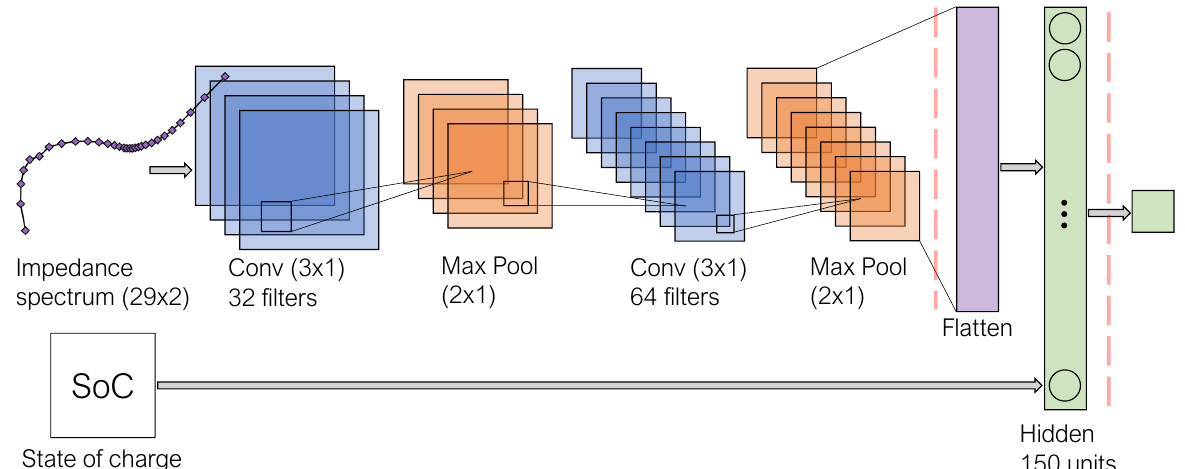
Figure 1. Diagram of the convolutional neural network architecture employed for direct estimation of state of health using impedance spectroscopy measurements—with the real and imaginary components of the battery impedance at each sampling frequency forming a 29 × 2 input matrix, respectively—and battery state of